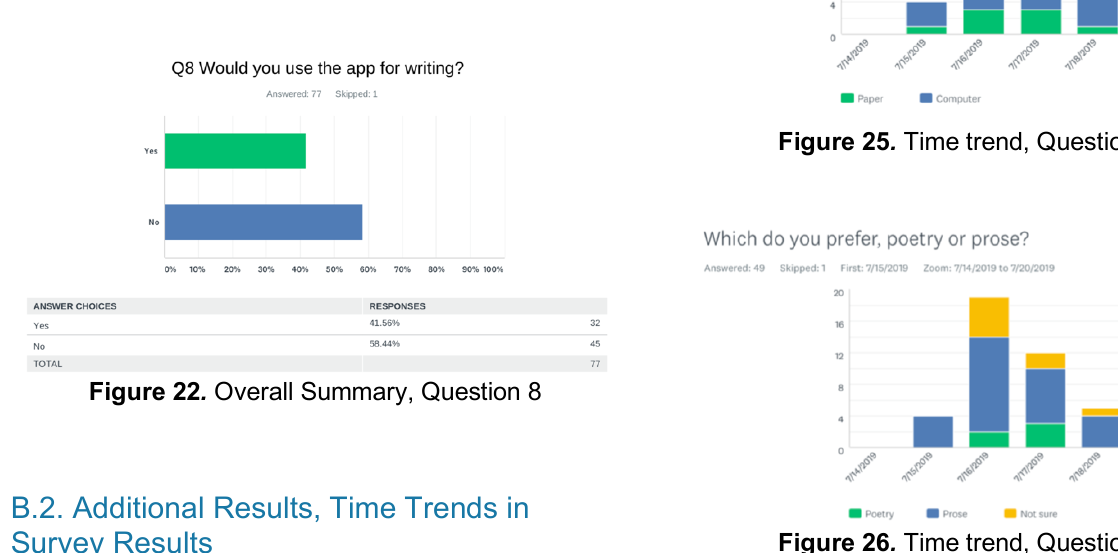
Figure 21 . Overall Summary, Question 7